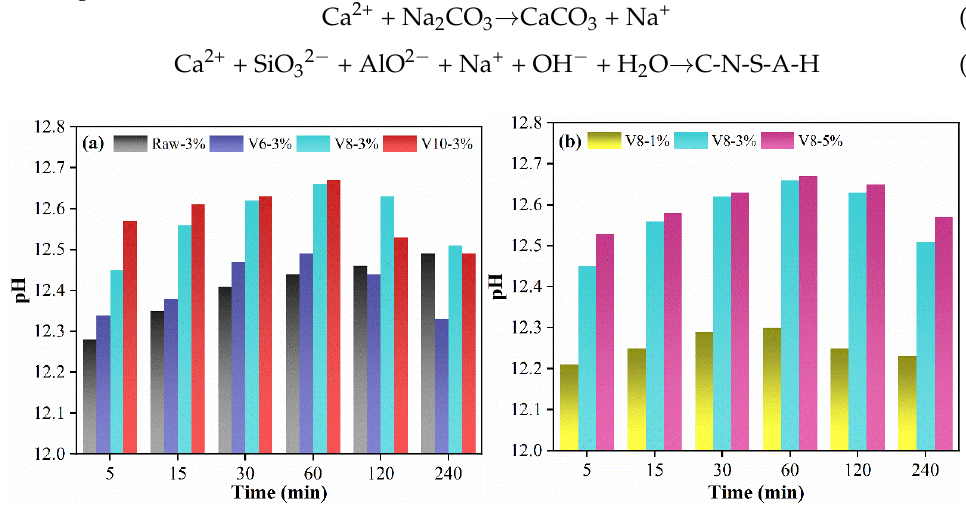
Figure 6. pH value of the leaching solution of SS-BFS-based AAMs: effect of BFS fineness ( a ) and effect of NC dosage ( b ).